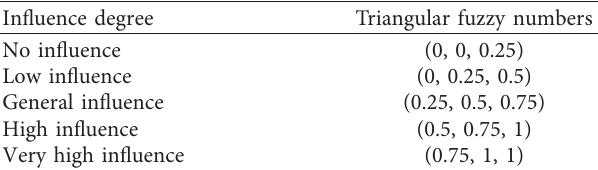
Table 1: Influence degree and triangular fuzzy